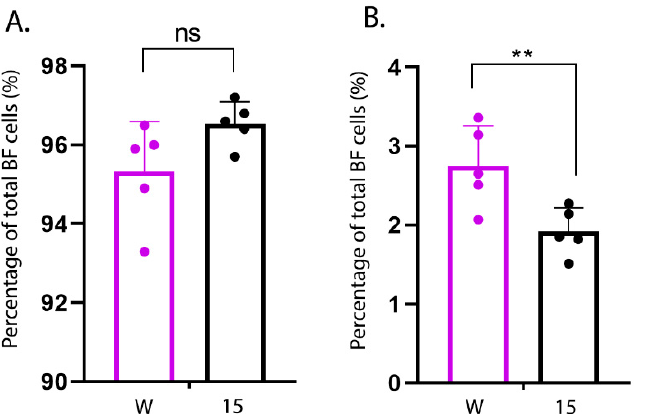
Figure 7. Bursal cells isolated from line W birds contained a greater proportion of KUL01+ cells than cells isolated from line 15 birds. Primary bursal cells were isolated from the BF of uninfected line W and line 15 birds ( n = 5). Cells were stained with mouse monoclonal antibodies raised against either the B cell marker Bu1, or the macrophage cell marker KUL01. Cells were subjected to flow cytometry and the proportions of Bu1+ cells and KUL01+ cells in the BF cell populations were determined (shown as percentages in A and B , respectively). Data passed Shapiro–Wilk normality tests before being analysed by one-way ANOVA and Tukey’s multiple comparison tests (** p < 0.01).